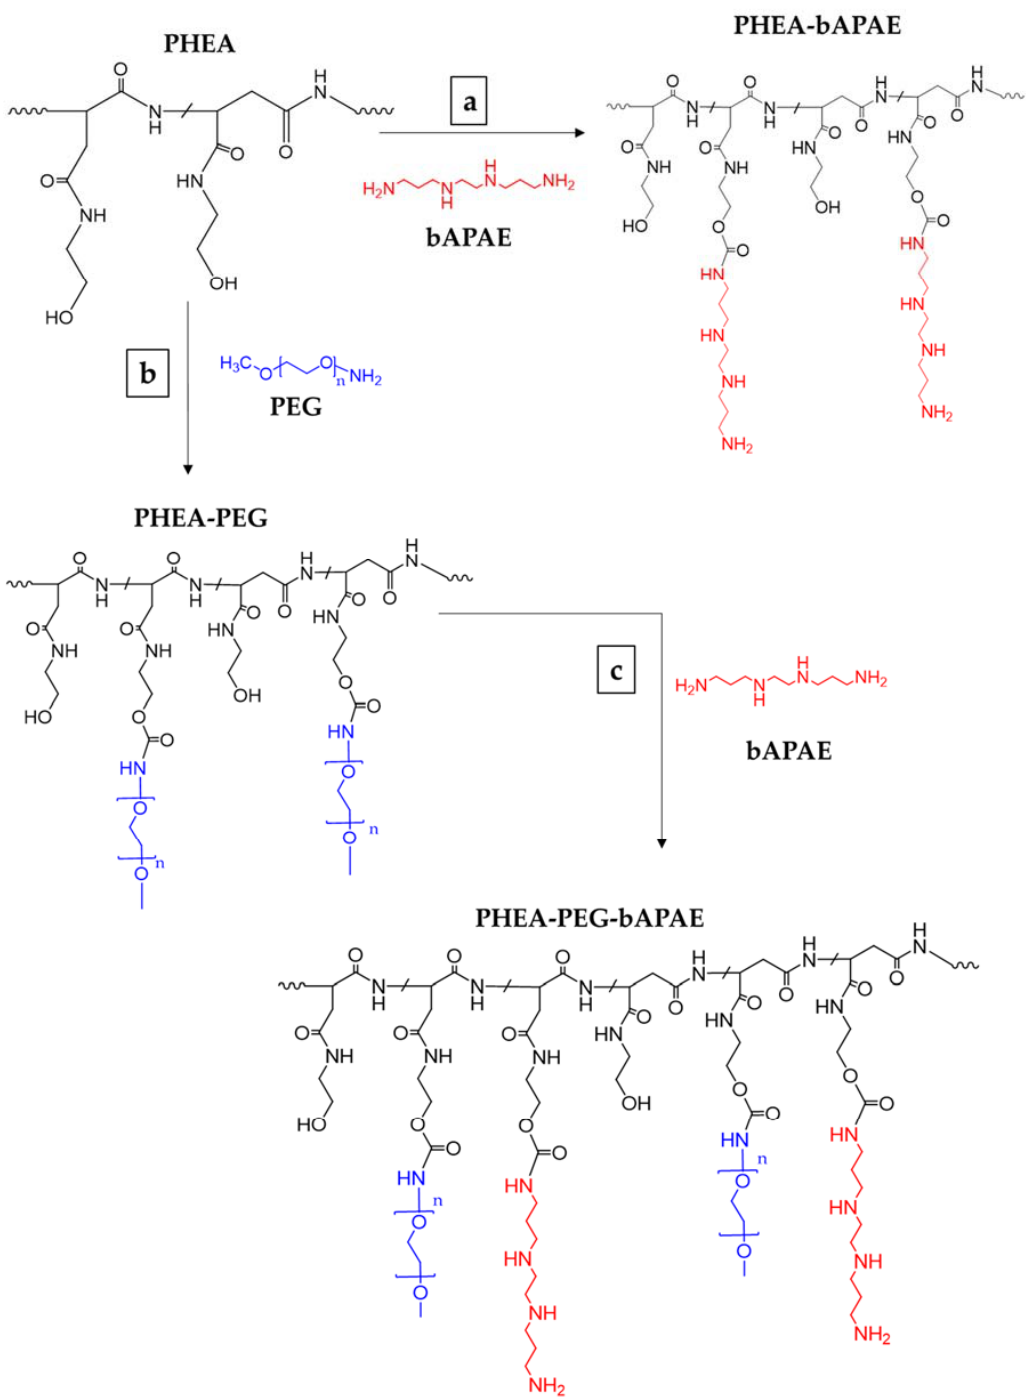
Figure 2. The synthetic route of ( a ) PHEA ‐ g ‐ bAPAE and ( b ) PHEA ‐ g ‐ PEG and ( c ) PHEA ‐ g ‐ PEG ‐ g ‐ bAPAE graft copolymers ( n = 44). Reagents and conditions: a) a ‐ DMF, BNPC, 4 h at 40 °C, 20 h at 25 °C; b) a ‐ DMF, DSC, 4 h at 40 °C, 18 h at 25 °C; b) a ‐ DMF, BNPC, 4 h at 40 °C, 20 h at 25 °C. a-DMF, DSC, 4 h at 40 ◦ C, 18 h at 25 ◦ C; b) a-DMF, BNPC, 4 h at 40 ◦ C, 20 h at 25 ◦